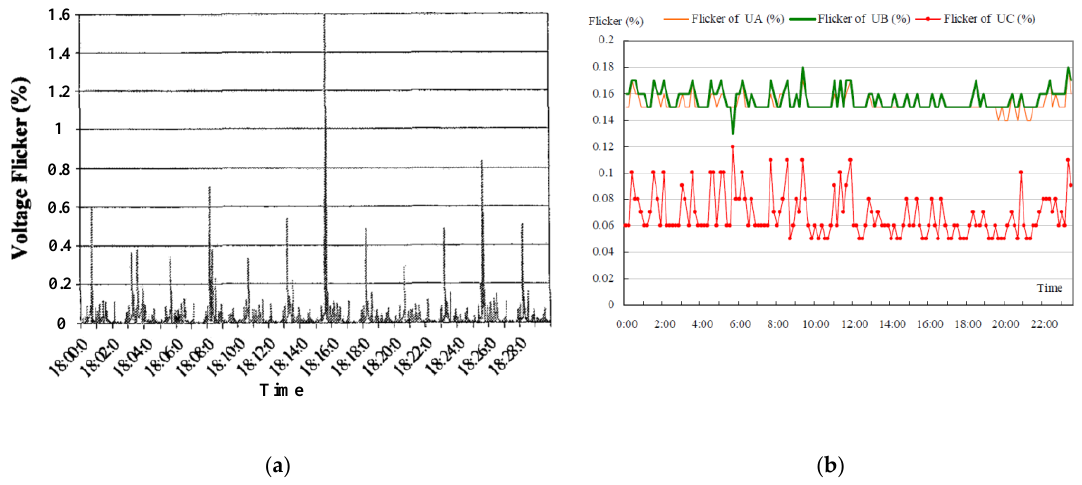
Figure 20. Measured voltage flicker in railway substation. ( a ) Short duration flicker [124]. ( b ) Long duration flicker in three-phase high-voltage busbar [41].